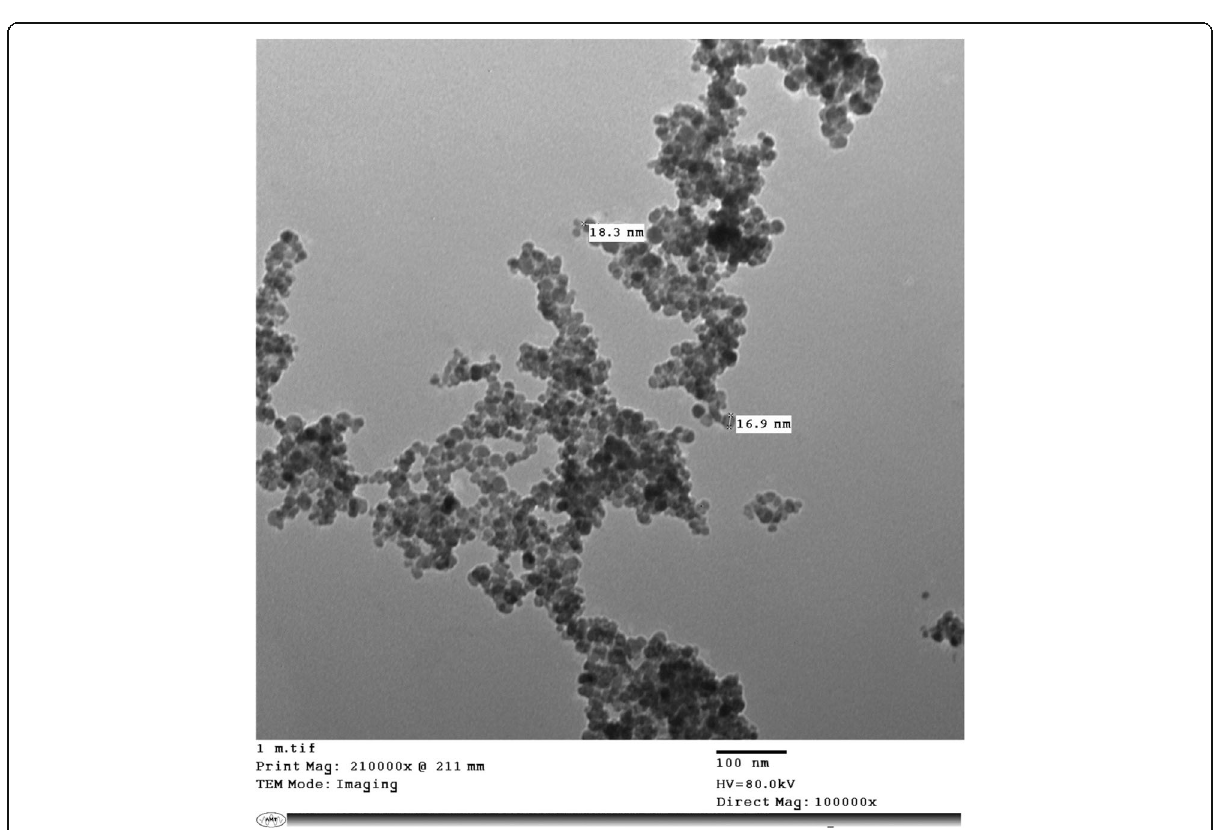
Fig. 1 Nanoparticles of zinc oxide composition average size of 17 nm (range from 16 to 18